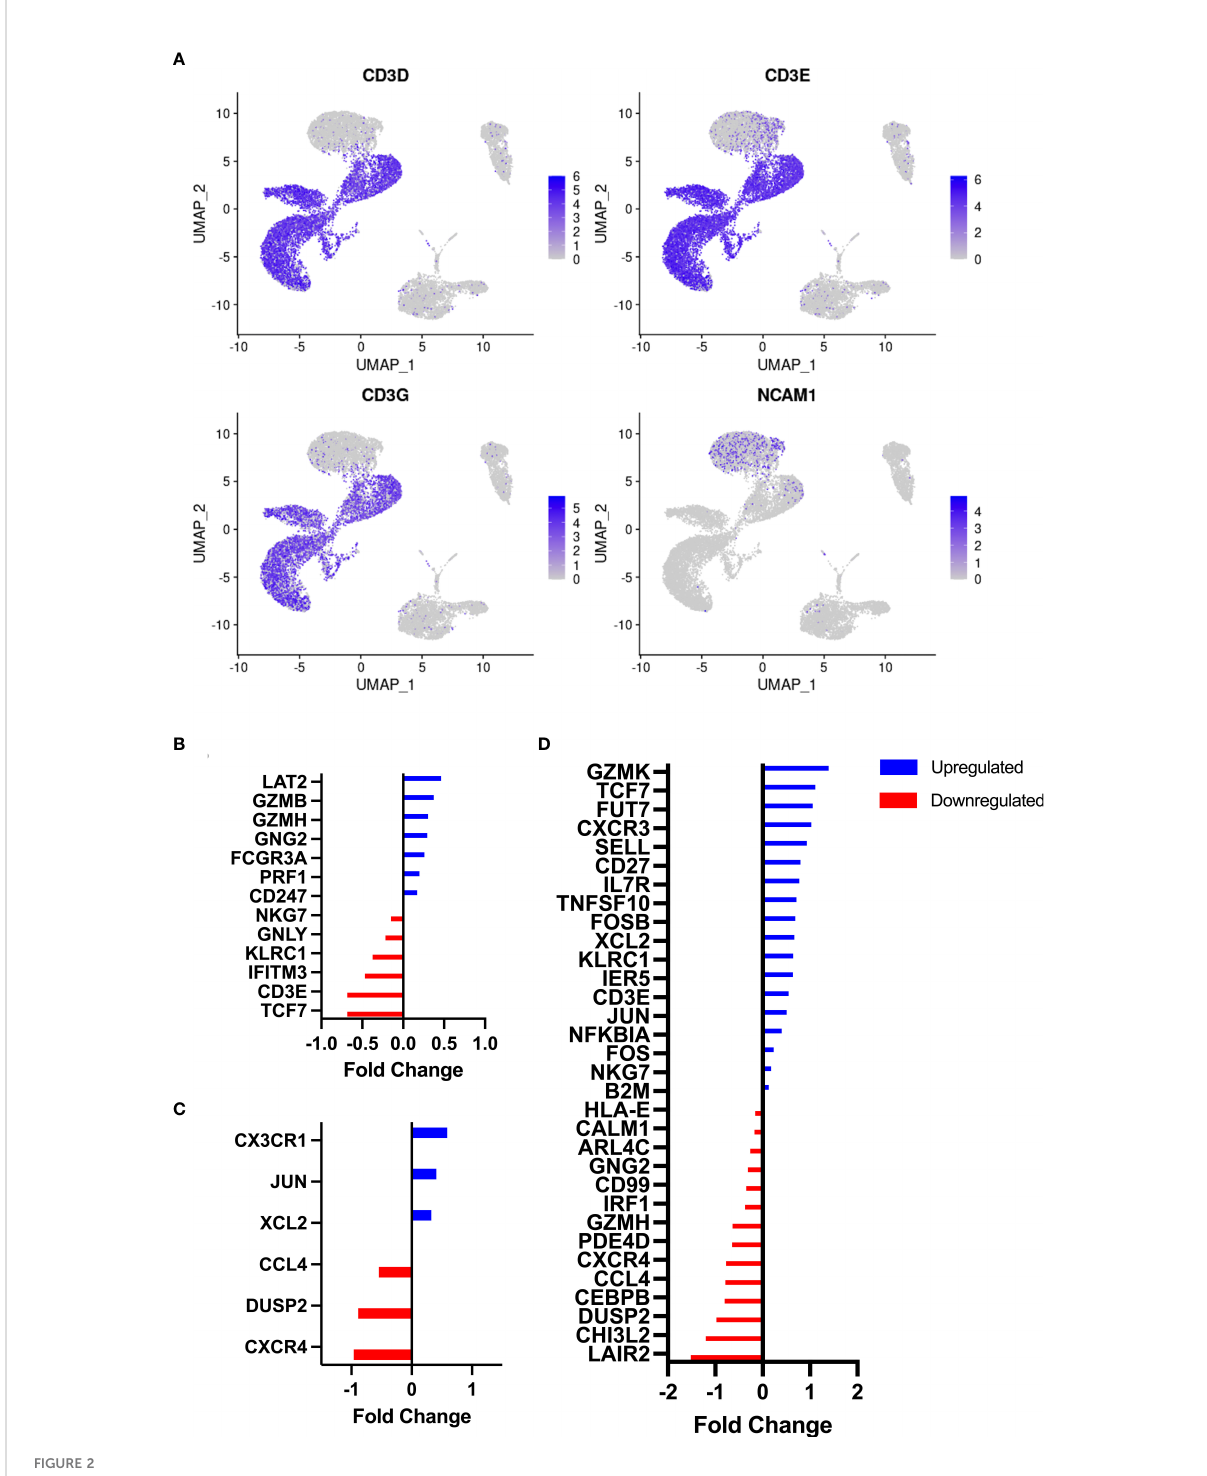
FIGURE 2 Identi fi cation of NKT-like cells by RNAseq and associated DEG analysis. (A) UMAP plots demonstrate clustering of CD3D, CD3E, and CD3G on resting PBMCs ( n = 3). NKT-like cells were identi fi ed by the overlap of NK-cell marker NCAM1 and CD3 clusters. Differentially expressed genes on NKT-like cells were identi fi ed between timepoints, (B) Rest vs 80%, (C) Rest vs +1H, and (D) 80% vs +1H. Blue and red bars denote the upregulation and downregulation of DEGs, respectively. All are statistically signi fi cant